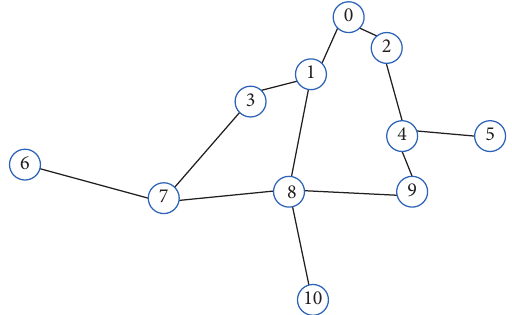
Figure 4: The topology of the small HSR